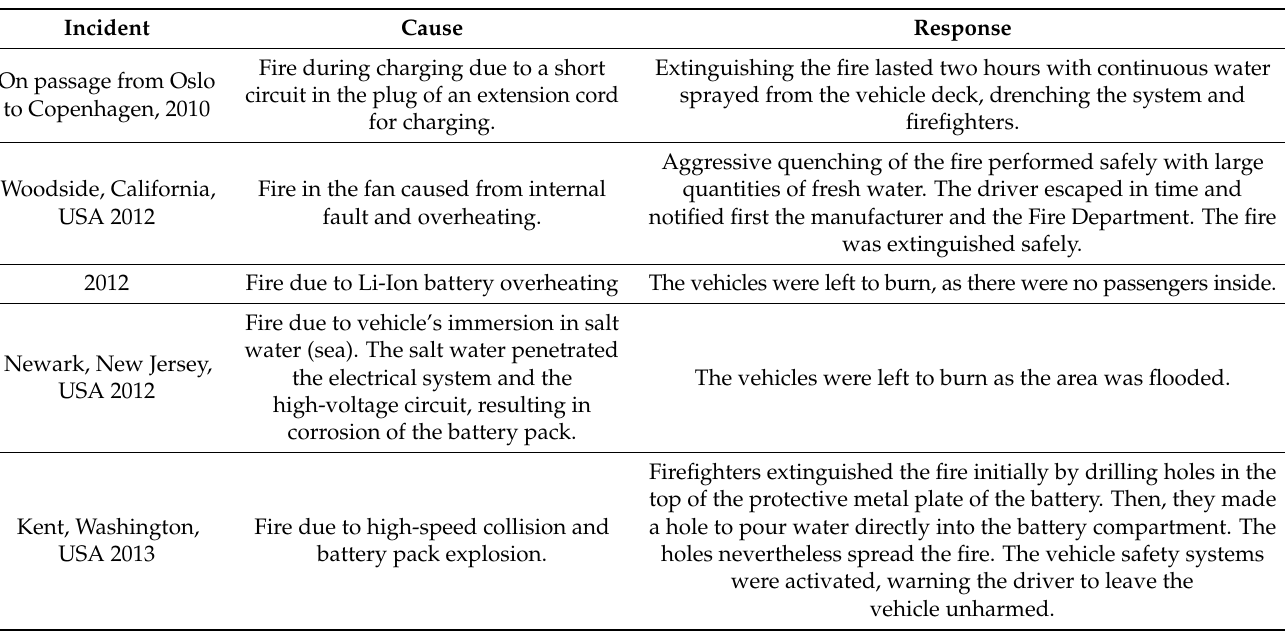
Table 1. Indicative accidents with electric cars and ways to deal with them